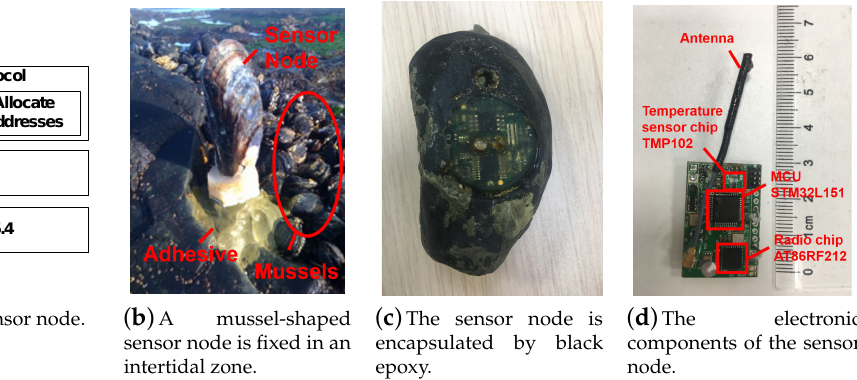
Figure 9. The design of the sensor node: ( a ) the diagram of the sensor node; ( b ) how we deploy sensor nodes in the intertidal area; ( c ) a customized mussel-shape sensor node which is designed for environmental monitoring, and the node is covered by epoxy for waterproof; and ( d ) the electrical components of the sensor